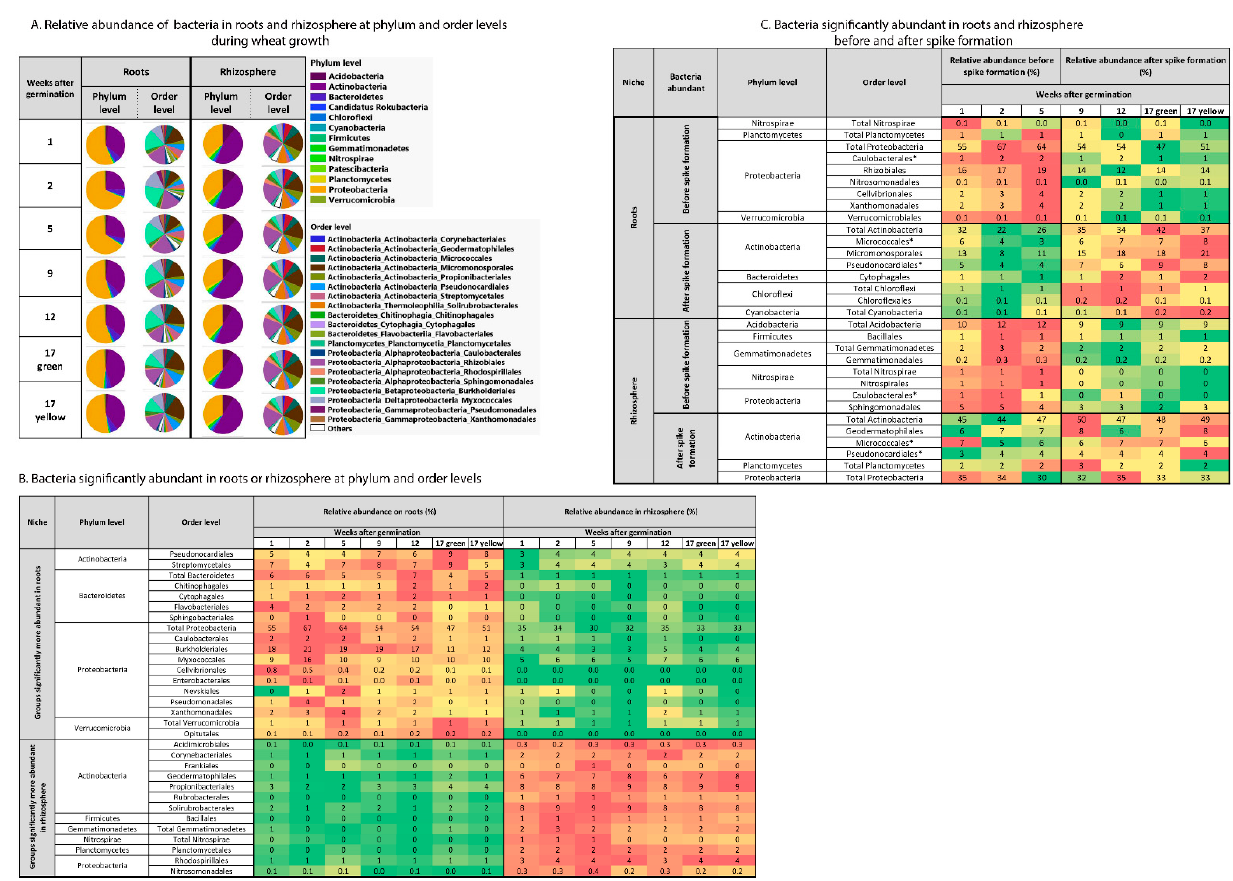
Figure 4. Changes in root-associated and rhizosphere bacterial community structure as a function of niche (roots vs. rhizosphere) and plant age. ( A ) Shifts in root and rhizosphere bacterial community structure at the phylum and order levels as influenced by plant age. Significantly abundant groups in root or rhizosphere (niche) ( B ) and with spike formation ( C ). Changes in bacterial abundance were calculated using DESeq2 with cutoff FDR-adjusted p -value < 0.05. Before spike formation, n = 9; after spike formation, n = 10. Asterisk (*) indicate bacteria groups at order level, that their abundance in root and rhizosphere microbiome was influence by spike formation.